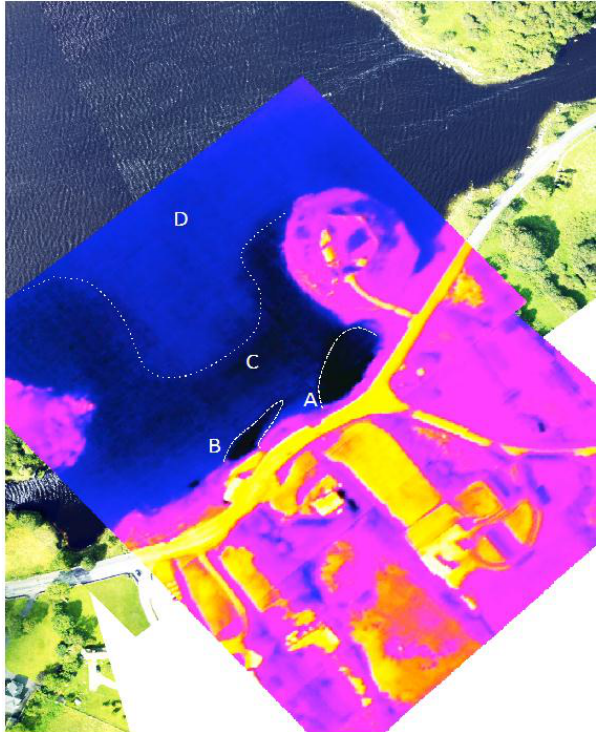
Figure 11. Thermal Imagery of Kinvara Bay collected using LWIR Thermal Imager interpolated with high-resolution imagery collected using a Nikon D800E SLR camera. Colder freshwater sources are clearly visible near the shore ( A , B ) as is a more extensive area of cooler water ( C ) which gradually merges with warmer water ( D ).